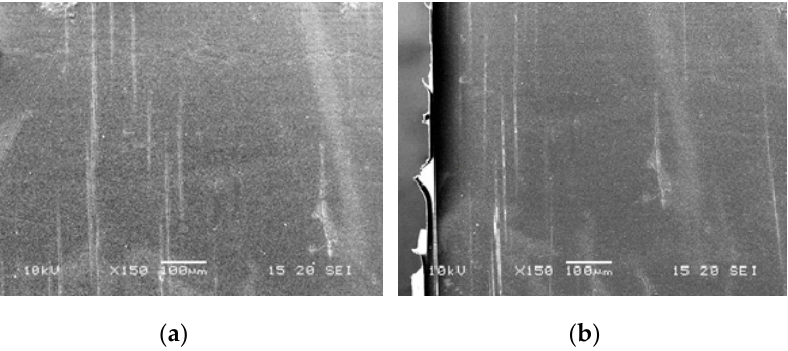
Figure 6. In situ observation of craze formation in the PLA/PHA blend originated by crack nano-bridge toughening via PLA fibers. Uniaxial deformation inside SEM microscope. The respective deformations are 0.049 ( a ) and 0.071 ( b ).